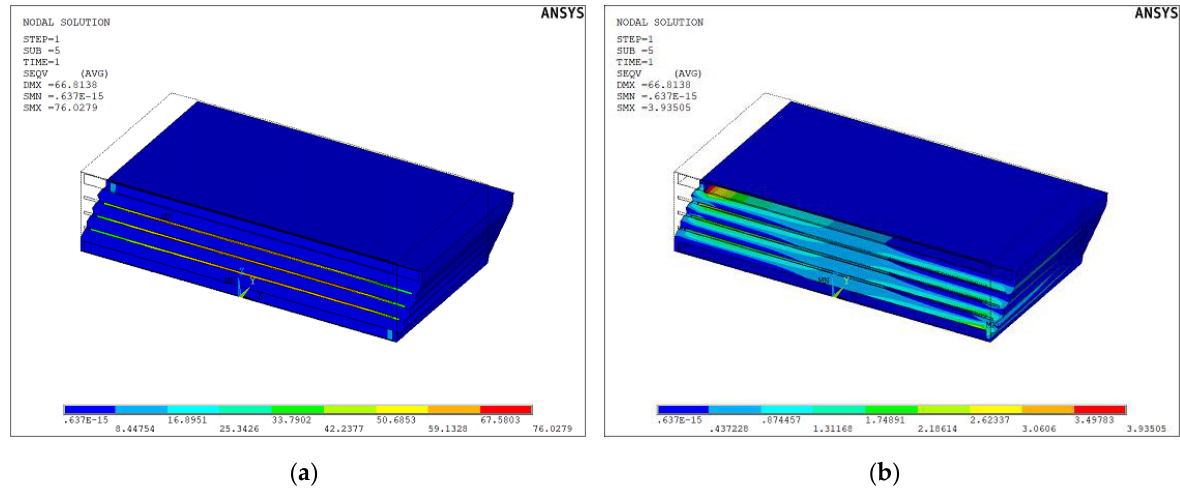
Figure 9. Stress distribution of elastomeric bearing with 5P M-R model as shear strain is 0.5 under the vertical pressure of 6 MPa: ( a ) for all domain; ( b ) for elastomer only.